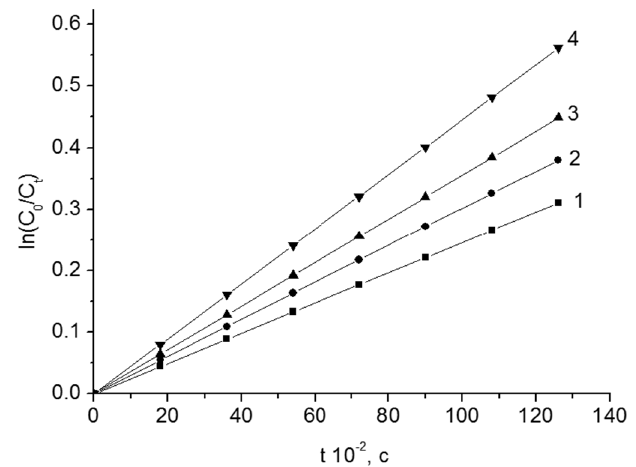
Figure 2. The kinetic curves of the thermal decomposition of BP in styrene. T = 348 K. Fe 2 O 3 content, wt.%: 1–0; 2–4.0; 3–9.2; wt.%: 1–0; 2–4.0; 3–9.2; 4–15.3.